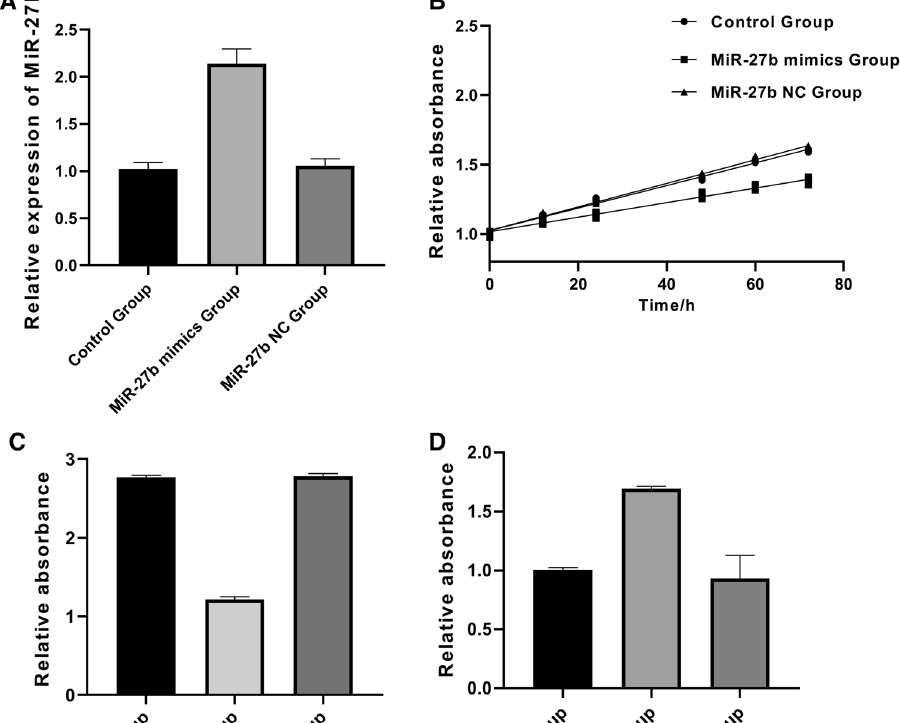
27b mimics group decreased (P < 0.05); C : The